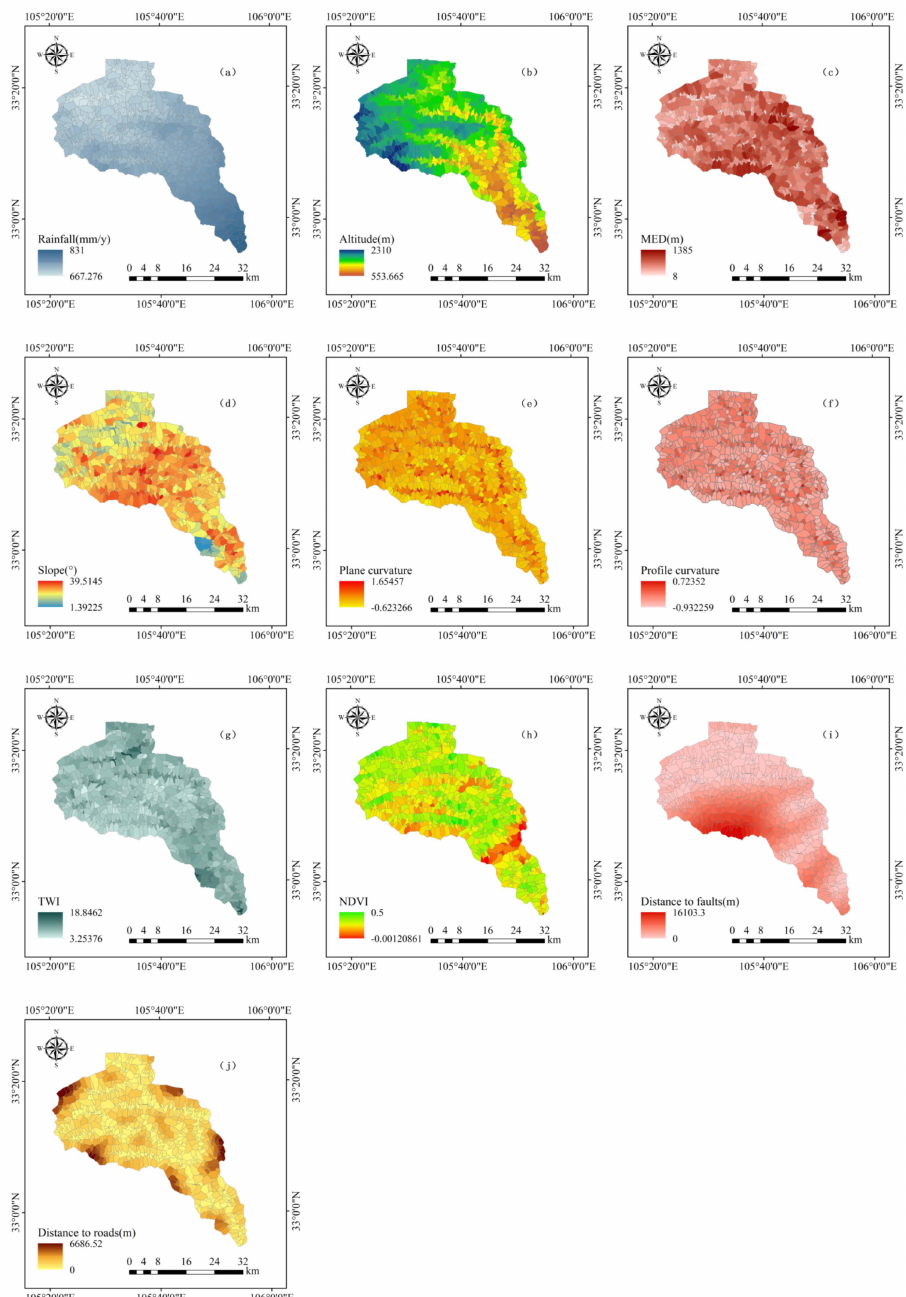
Figure 3. Conditioning factors of Yanzi River Basin: ( a ) Rainfall; ( b ) Altitude; ( c ) MED; ( d ) Slope; ( e ) Plane curvature; ( f ) Profile curvature; ( g ) TWI; ( h ) NDVI; ( i ) DTF; ( j )